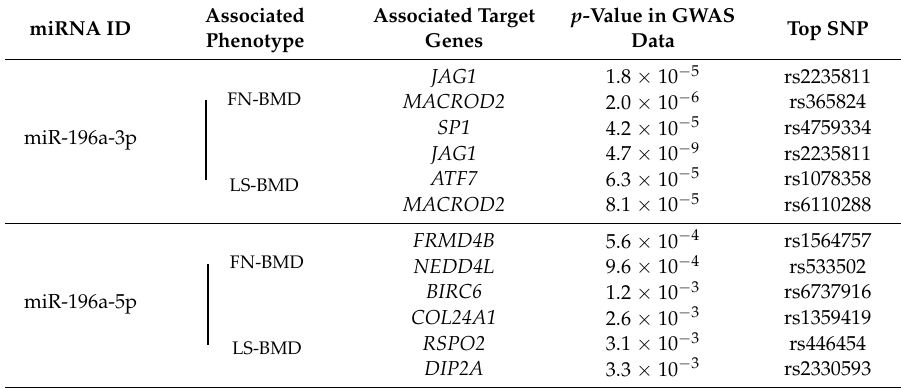
Figure 3. Expression of the highlighted miR-196a-2 target genes and positive controls ( SP7 , MEPE , RUNX2 , SOST and SPP1 ) in RNA-seq data consisting of 86 hip bone (iliac crest) biopsies. The expression data are shown in the metric Log10 FPKM (fragments per kilobase of transcript per million mapped reads). Table 1. Putative target genes of miR-196a-2 (3p and 5p) that are associated with FN-BMD and LS-BMD. Leading SNPs within each target gene associated with BMD in GEFOS GWAS data are shown. Significantly associated genes, after Bonferroni correction for multiple testing ( p -value <7.0 × 10 −6 ), are depicted in bold.